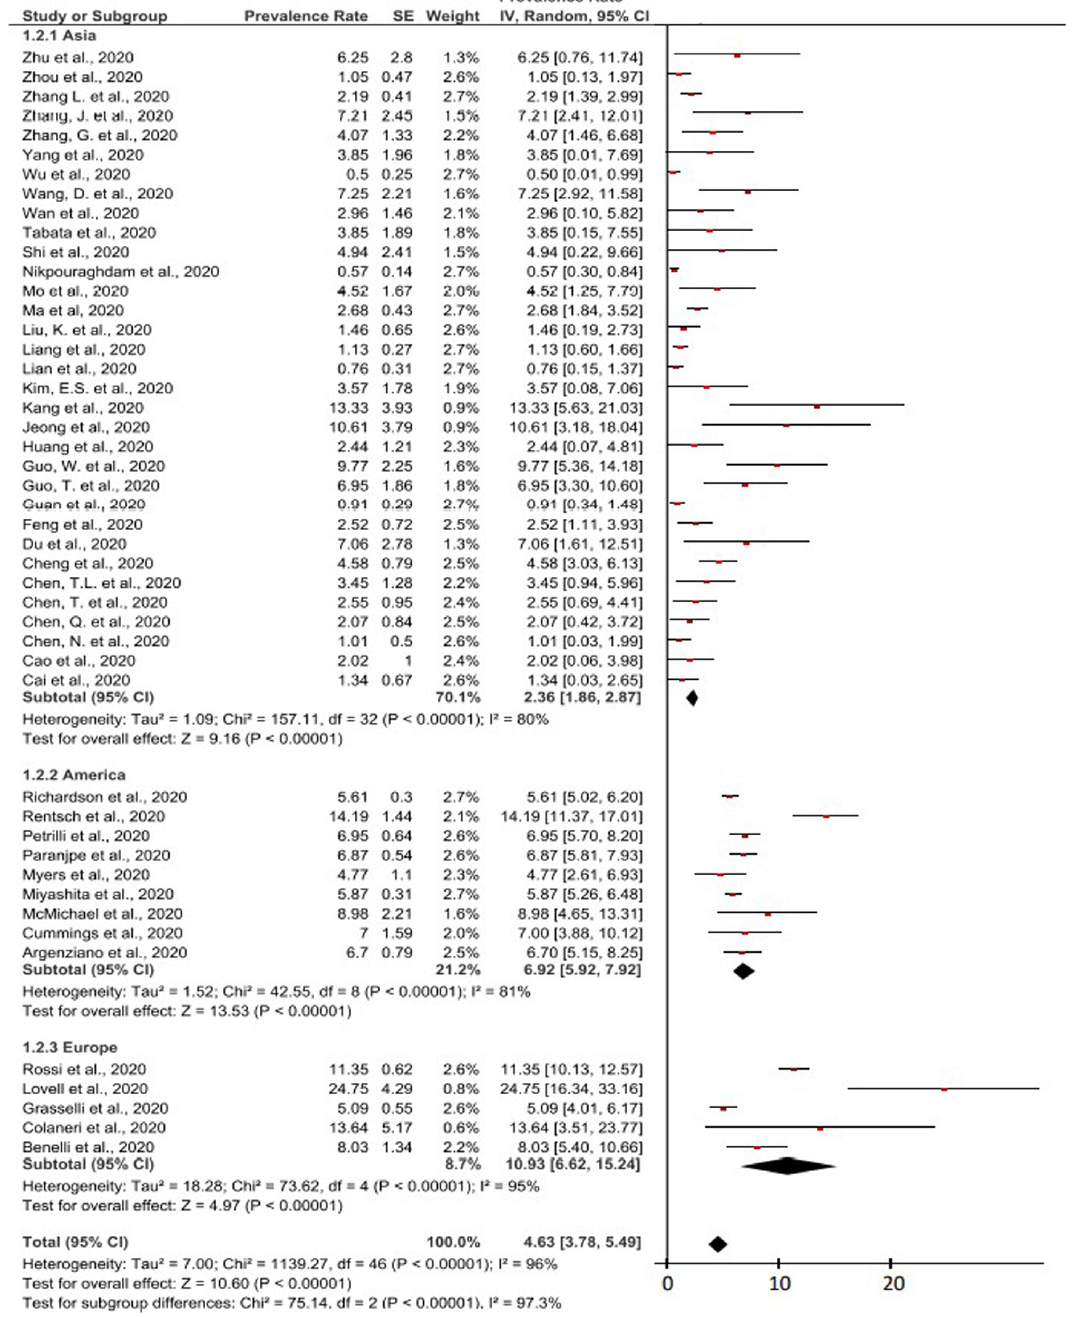
Figure 2. Forest plot of the prevalence of cancer as a comorbid in COVID-19 patients by